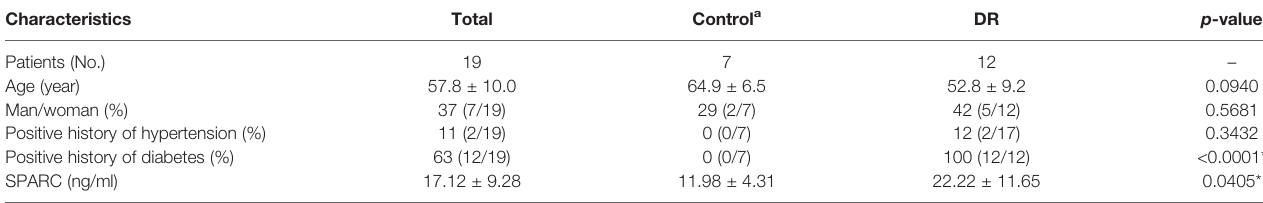
TABLE 1 | Demographic and clinical characteristics of patients. Characteristics